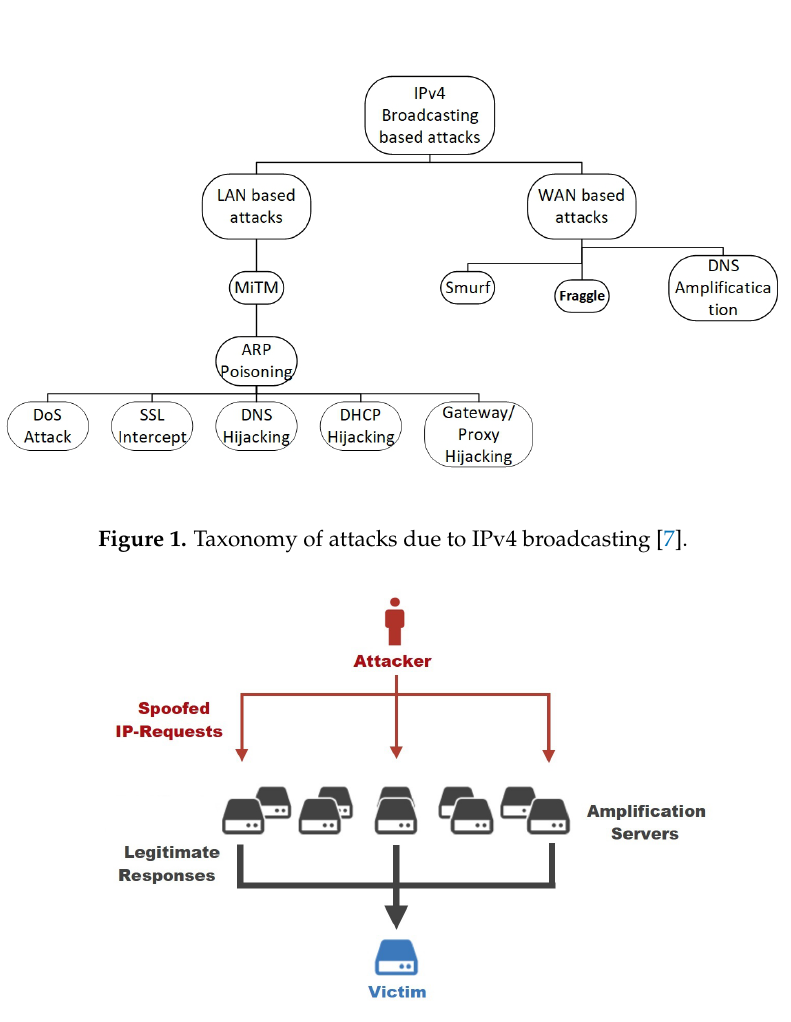
Figure 2. Typical DoS